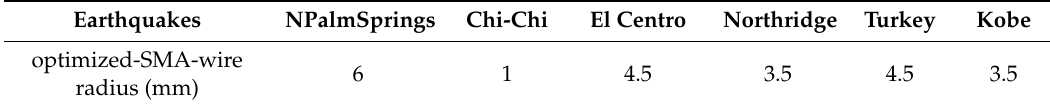
Table 4. Optimized radii obtained from NSGA-II for each ground motion record. Earthquakes NPalmSprings Chi-Chi El Centro